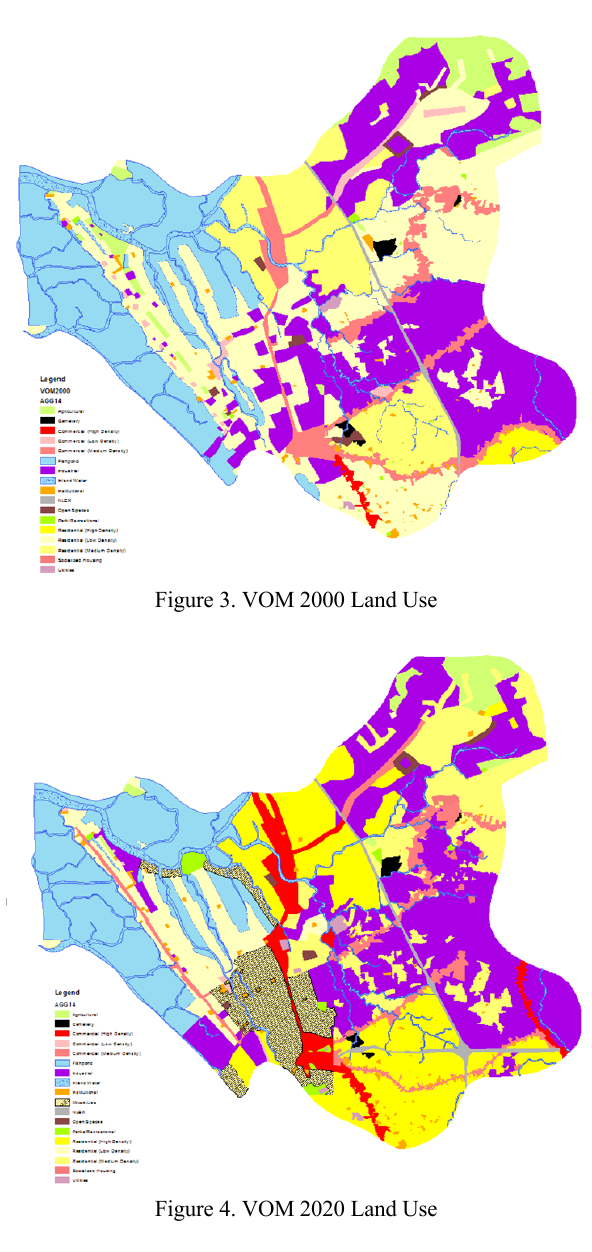
Figure 4. VOM 2020 Land